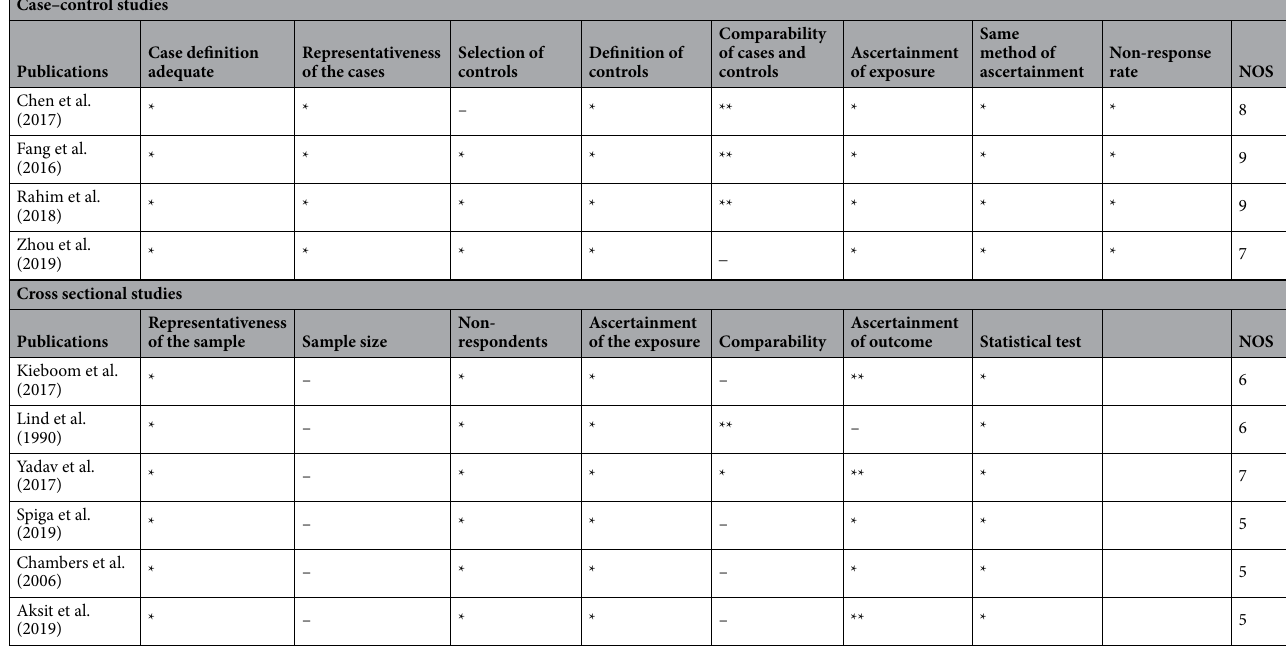
Table 2. Quality of included studies according to Newcastle–Ottawa Scale (NOS).